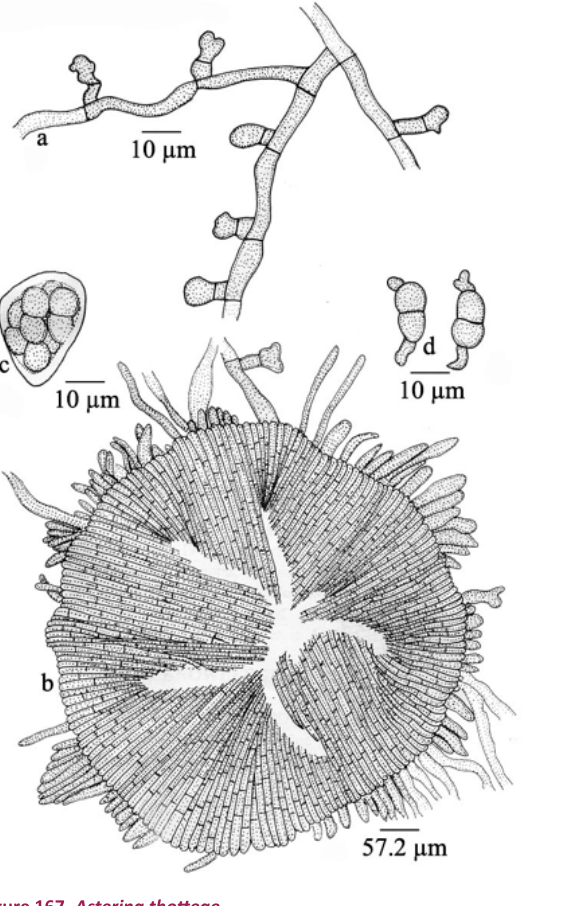
Fig. 168. Asterina toddaliae a.Appressorium, b. Thyriothecium, c. Ascus, d.